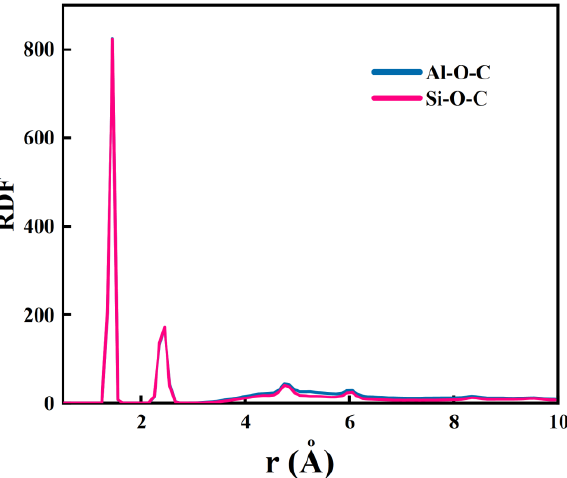
Figure 15. Radial distribution function of the oxygen atom to carbon atom of PEO for kaolinite 001 surface and 00 1̅ surface.